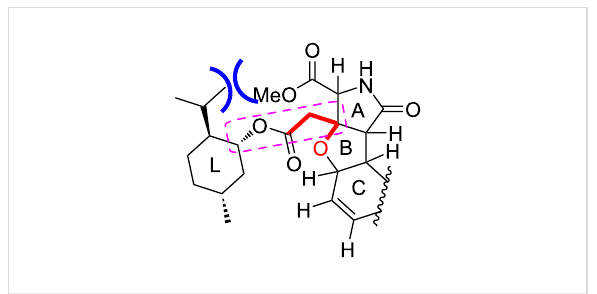
Figure 9: Key interactions that are supposed to control the spatial arrangement of the heterotricycle and the menthyl rings in 10 , 10* , 21 , and 21*